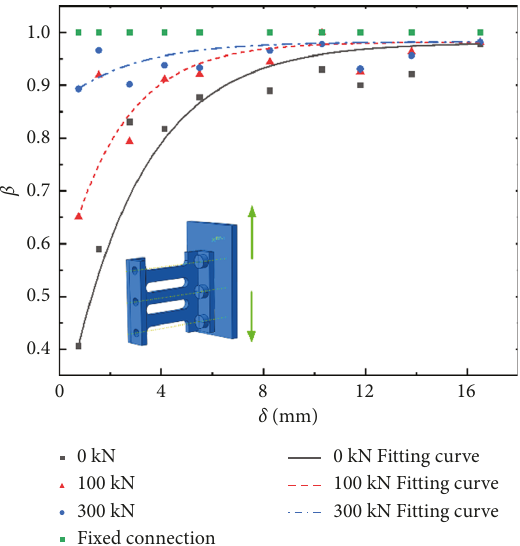
Figure 24: The relationship between yield energy dissipation co- efficient β and displacement δ .